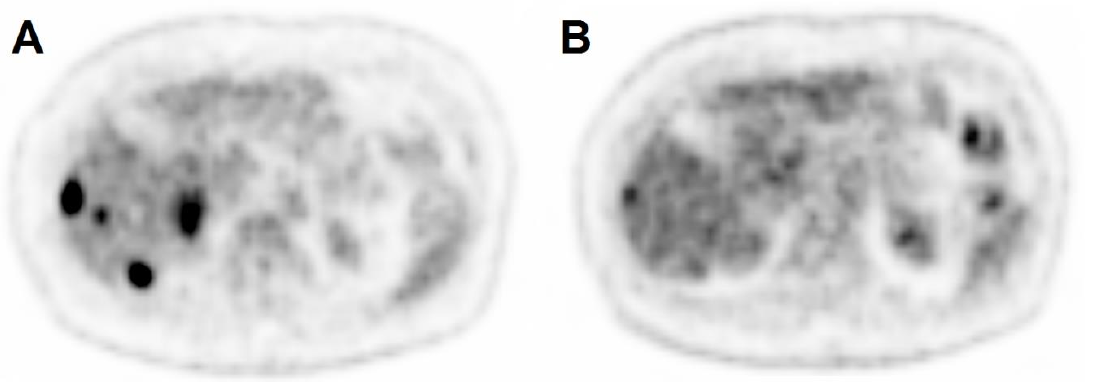
Figure 5. Case example of visual increase in [ 18 F]FDG activity concentration in non-tumorous liver tissue. A 75 year old woman with colorectal liver metastases underwent a [ 18 F]FDG-PET/CT prior ( A )